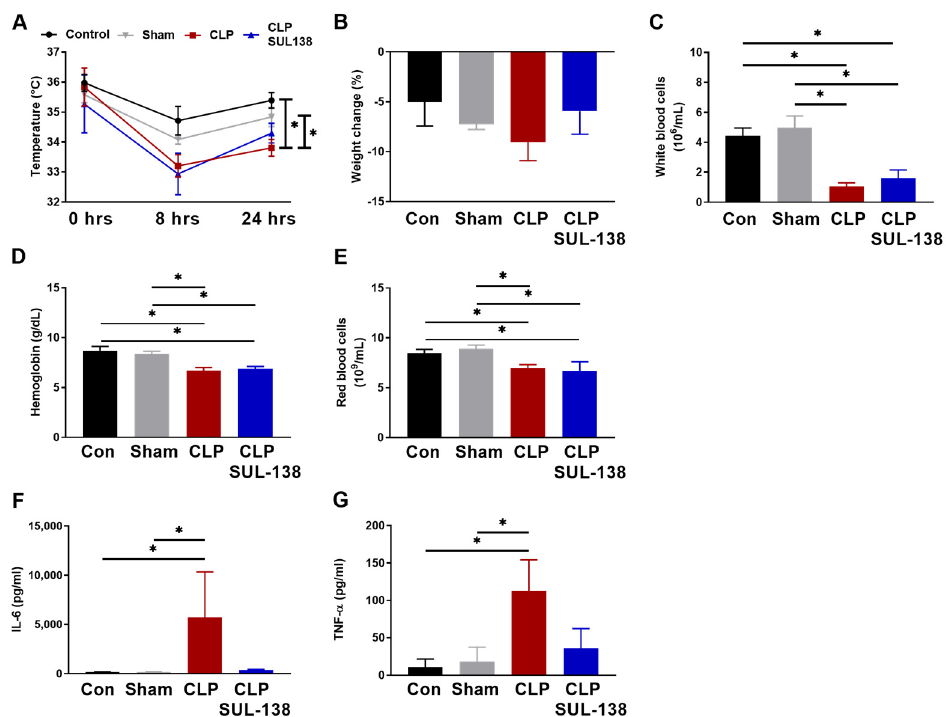
Figure 5. SUL-138 limited the increase in CLP-induced systemic inflammation as evidenced by the normalization of circulating cytokines in mice. Mice treated with SUL-138 (5 mg/kg) were injected s.c. 2 h before induction of CLP, followed by a second dose at 10 h after induction of CLP. Blood samples were drawn 24 h after sepsis induction. ( A ) Xiphoid temperature was reduced in the CLP group, while xiphoid temperature in the CLP SUL-138 group was not significantly reduced after 24 h. ( B ) Body weight was unchanged between groups. ( C – E ) CLP reduced white blood cell counts, hemoglobin levels, and red blood cell counts, which were unaffected by SUL-138. ( F , G ) CLP increased IL-6 plasma and TNF- α levels, which were precluded by SUL-138. Control (n = 8), sham (n = 8), CLP (n = 8) and CLP SUL-138 (n = 6). Data are represented as mean ± SEM, * p < 0.05. CLP, cecal ligation and